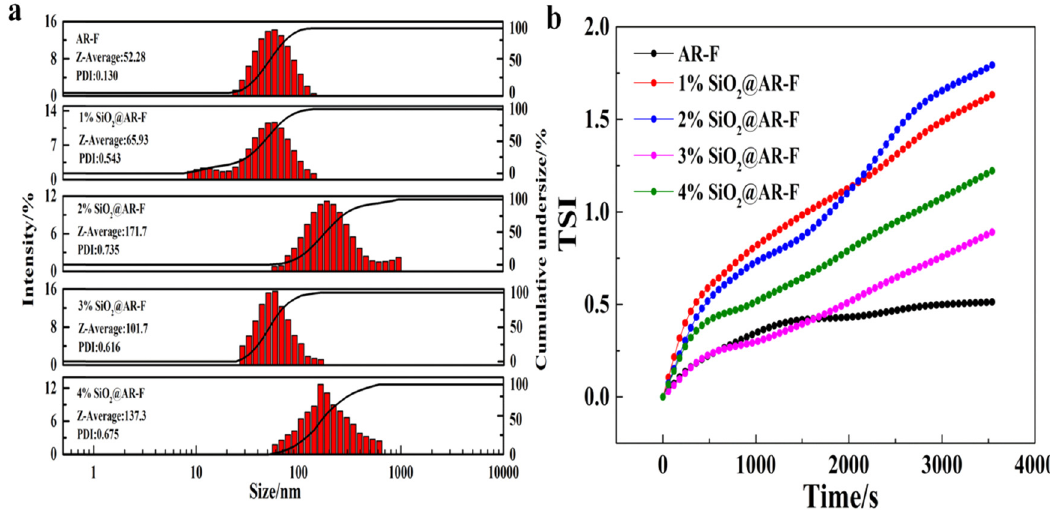
Figure 2: Emulsion particle size distribution ( a ) and emulsion stability ( b )